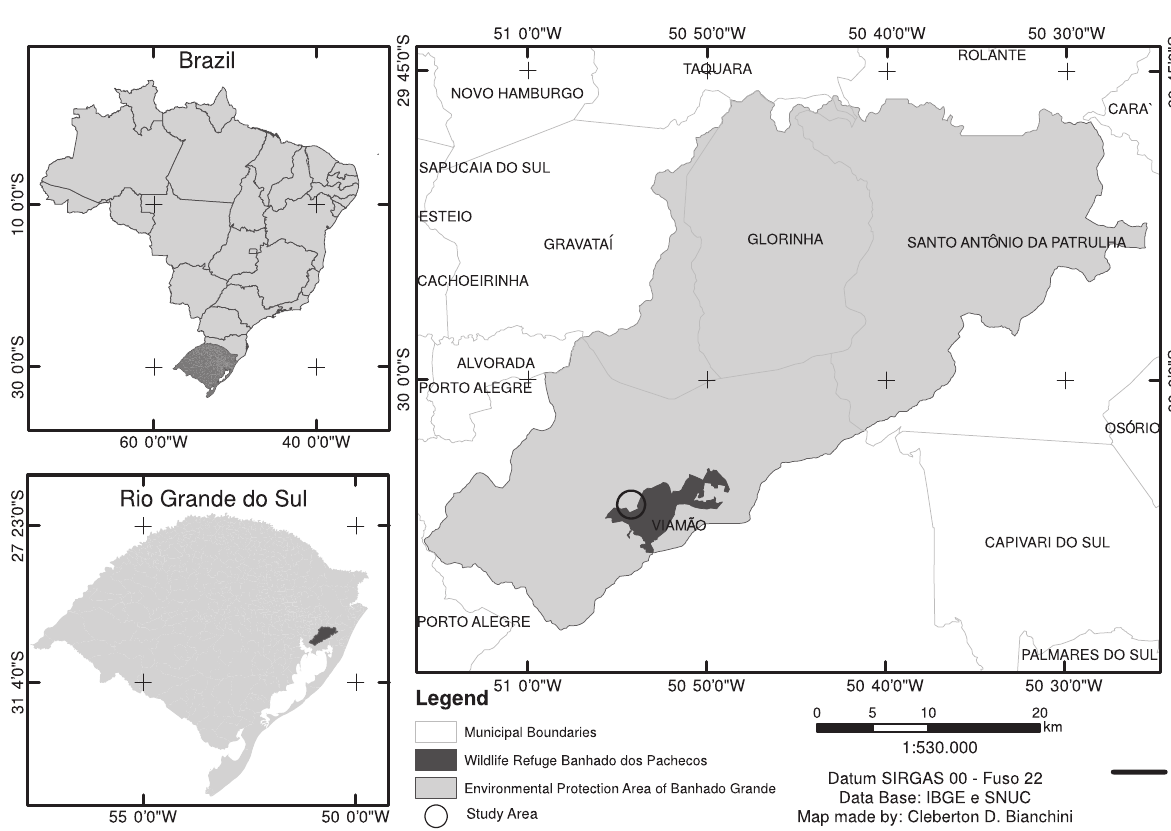
Figure 1. Map of study area, with the Wildlife Refuge Banhado dos Pachecos (WRBP) and, in its immediate vicinity, the Environmental Protection Area of Banhado Grande (EPABG), in the state of Rio Grande do Sul,